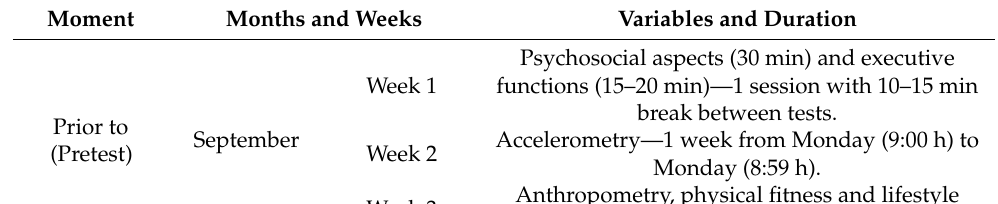
Table 2. ACTIVE VALUES data collection